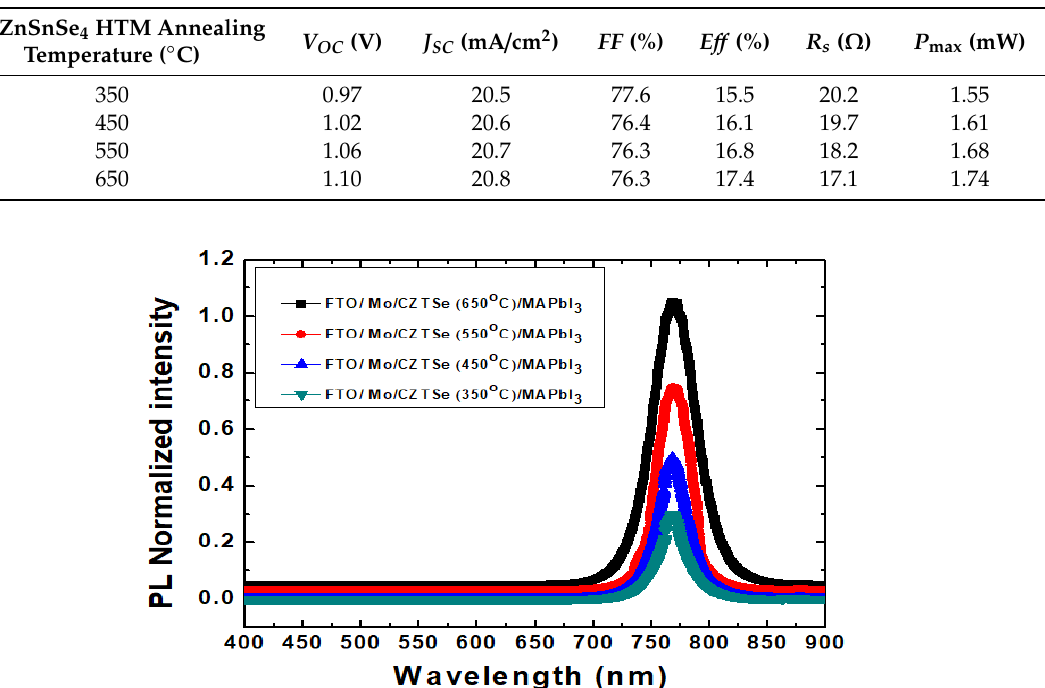
Figure 11. PL spectra of MAPbI 3 perovskite nano-films on Cu 2 ZnSnSe 4 / Mo / FTO following the various thermal annealing temperatures.